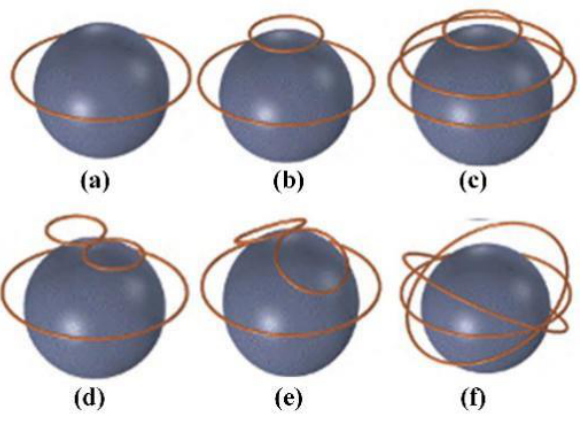
Table 3. Characteristics of the Halo coil model.